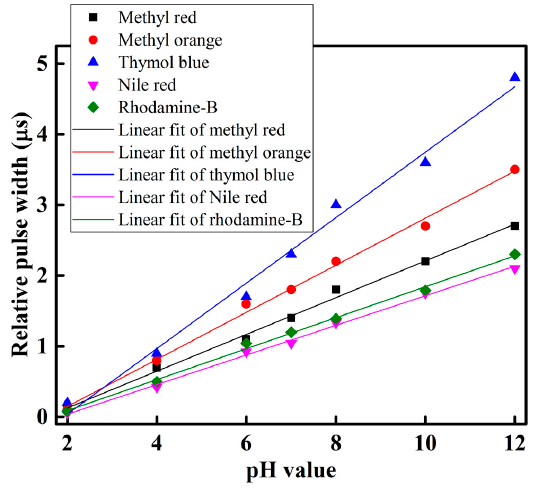
Figure 7. pH response of the proposed optical-fiber sensor array.